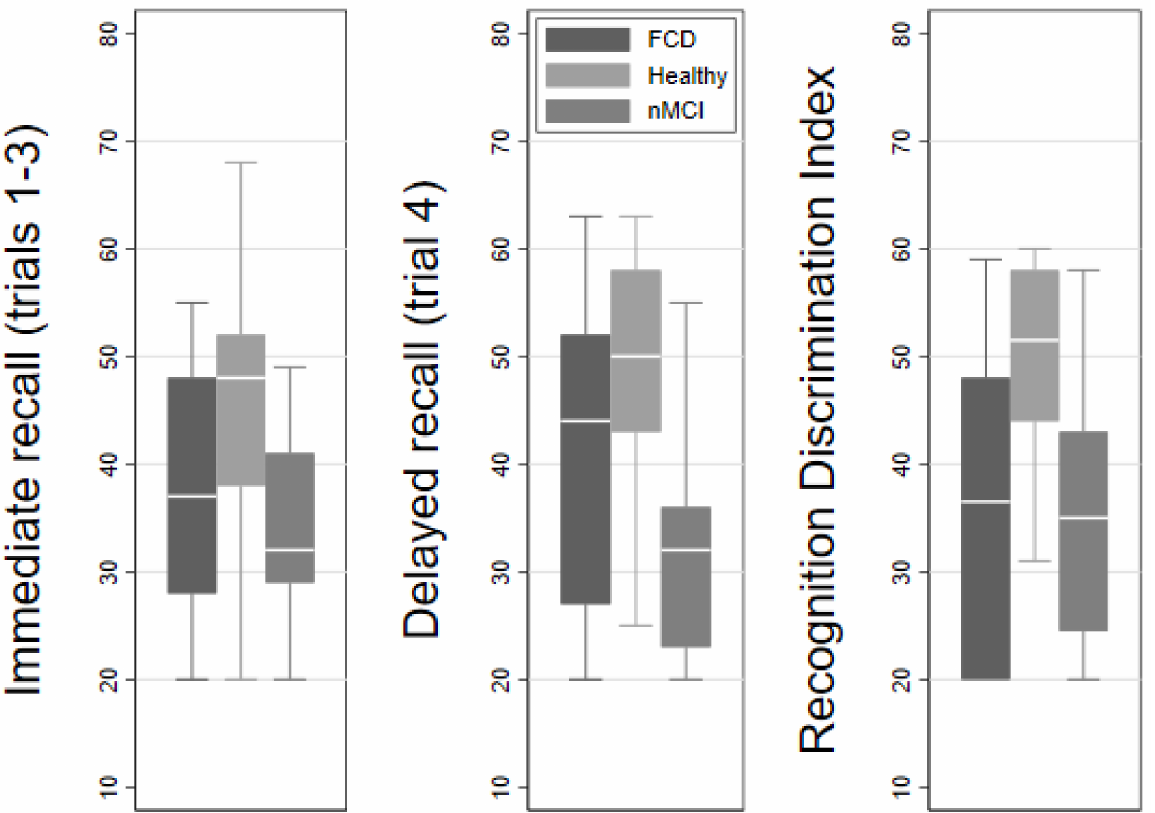
Figure 1. HVLT-R t -scores, demonstrating the discriminability of FCD from nMCI and Healthy Control groups, on measures of Immediate Recall, Delayed Recall, and